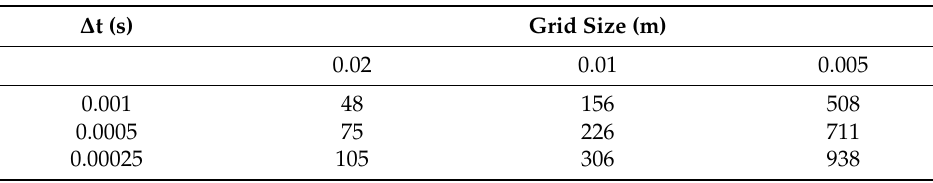
Table 1. Comparisons between the CPU times (s) with different time-steps and grid-sizes for the case of the dam-break flow passing a square cylinder.